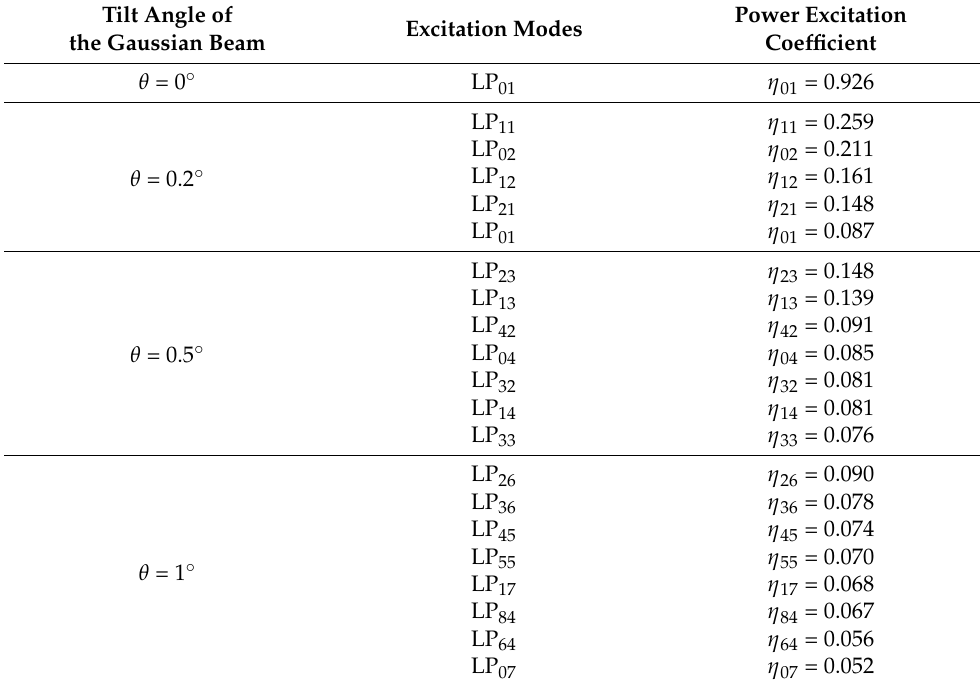
Table 1. Excitation modes and power excitation coefficients by varying the tilt angle θ of the Gaussian